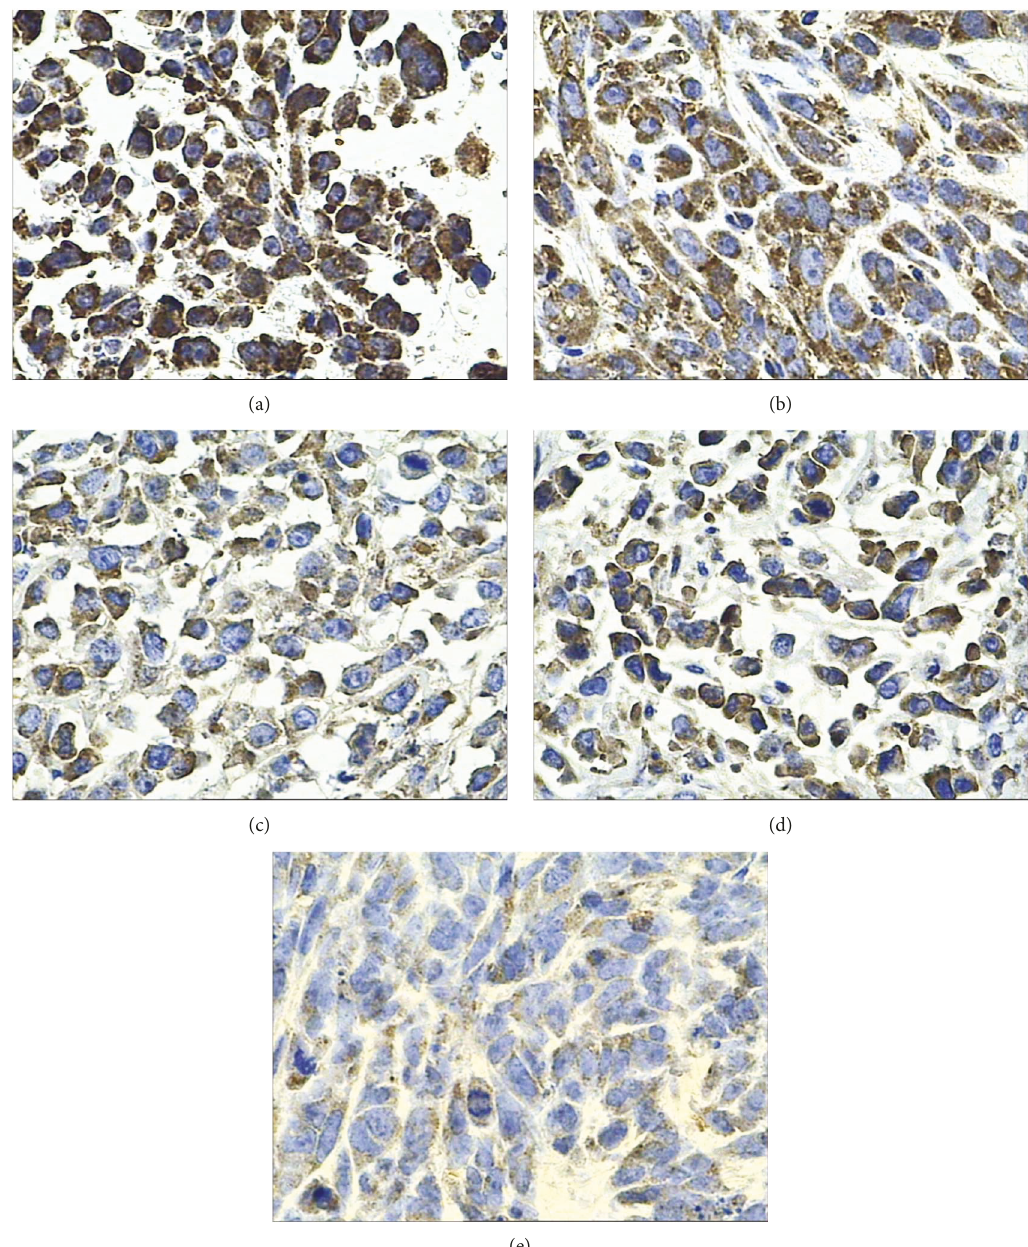
Figure 3: Livin protein expression in hepatoma tissues after di ff erent treatments tested by IHC (400x). (a) Saline control group. (b) Radionuclide group. (c) Radionuclide-gene group. (d) MFH group. (e) Radionuclide-gene-MFH